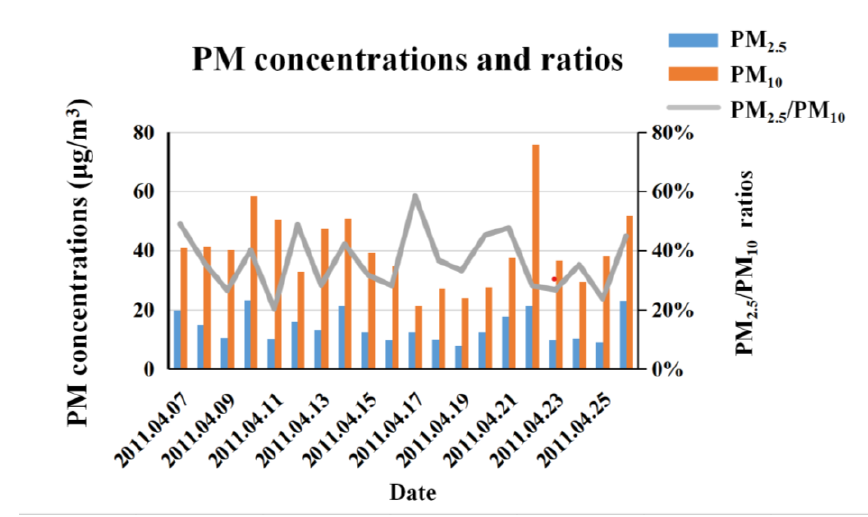
Figure 2. PM 2.5 and PM 10 mass concentration and size fraction. Table 2. PM 10 and PM 2.5 concentrations and ratios at clean / rural sites ( µ g / m 3